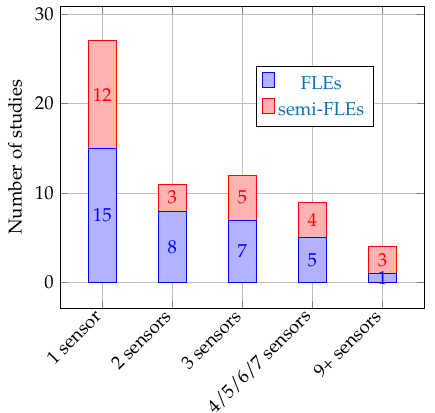
Figure 4. Distribution of studies according to the number of sensors associated with them: distinction between FLEs studies and semi-FLEs